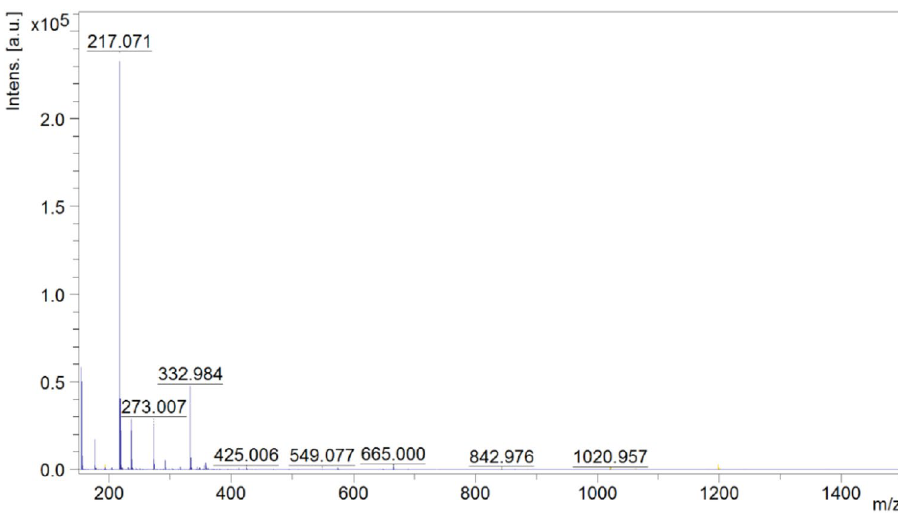
Figure 2. Mass spectrum of the ethylene polymerization product catalysed by [Cr(dipic) 2 ]Hdmbipy ∙ 2.5 H 2